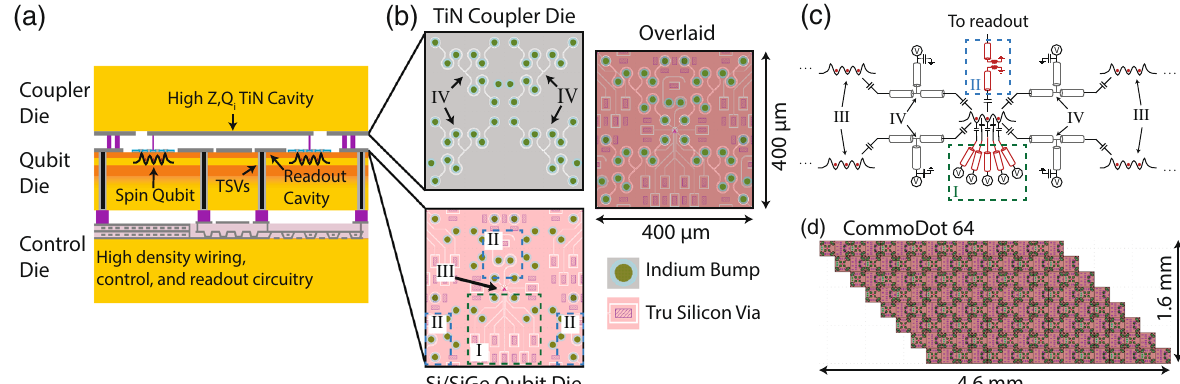
Fig. 1 Design of a 3D integrated cQED quantum dot processor. a Diagram of a cQED spin qubit processor utilizing a 3-tier stack. b Layout of an exchange only qubit cQED processor unit cell with a 0.16 mm 2 footprint. Top die consists of four λ /2 high-impedance resonators with λ /4 voltage taps. Base die consists of nine control lines (I), two readout resonators (II, one centered, 1/2 in each lower corner of the unit cell), and two qubits (III, one centered and 1/4 in each corner). Control and readout lines are routed to the backplane of the die using through-silicon vias (TSVs) with a 10 × 20 μ m 2 footprint 27 . c A simpli fi ed circuit schematic with the elements in red on the qubit die and the elements in gray on the coupler die. d A 64 qubit processor tiled out from the base tile design fi tting in a 4.6 × 1.6 mm 2